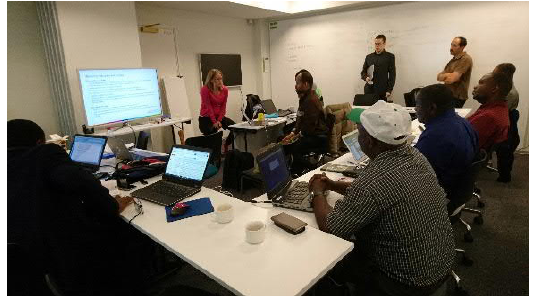
Figure 2. Discussing about strategical choices of the project in Turku between all the universities (September